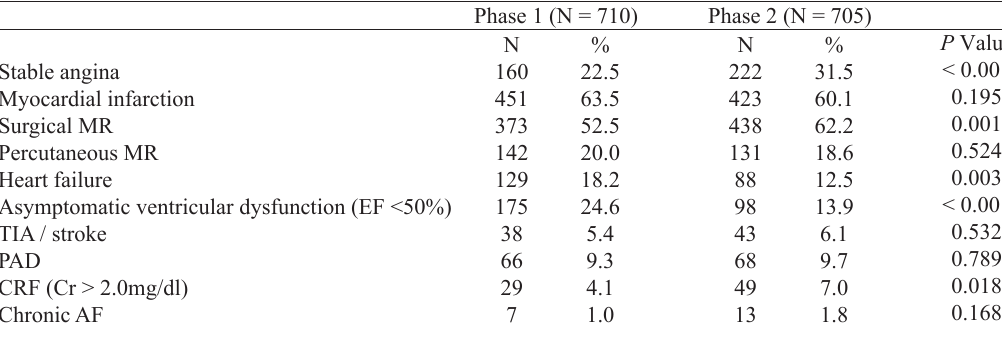
Table 1. Clinical